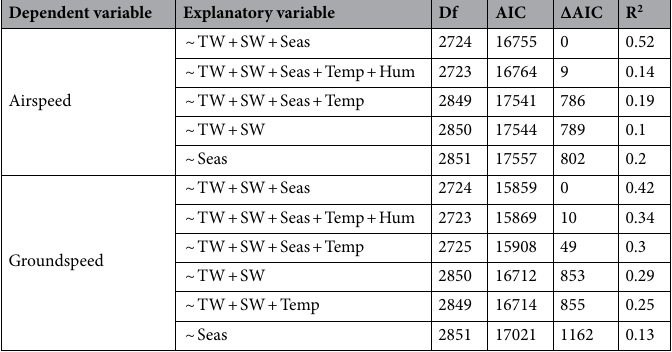
Table 2. Selecting the best LMMs for the airspeed and groundspeed during the Himalayas crossing. We listed first six models for each dependent variable. Models are ranked according to increasing ΔAIC values, with the best performing model on top. TW—tailwind; SW—sidewind; Seas—season; Temp—temperature; Hum—